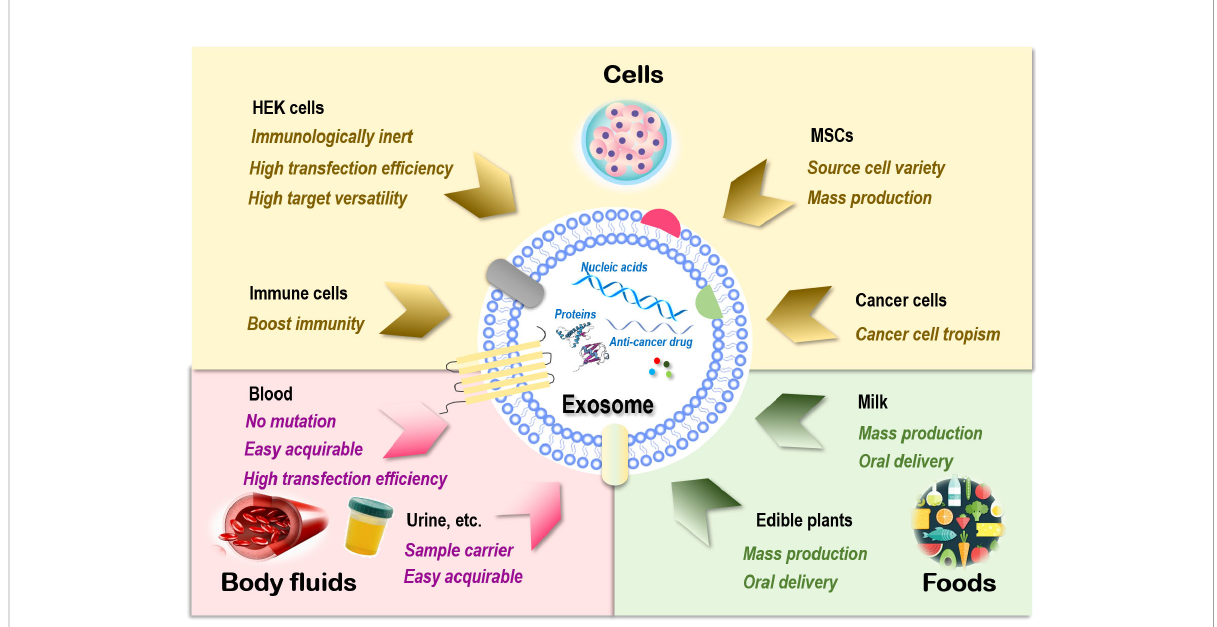
FIGURE 1 Sources of exosomes and their therapeutic advantages for drug delivery. Exosomes can be generated from almost all types of cells. Those are relevant to therapeutics fall into three main categories, i.e., cells, body fl uids, and food. There are four major cell sources for exosome generation, i.e., human embryonic kidney (HEK) cells, mesenchymal stem cells (MSCs), immune cells, and cancer cells. Exosomes of HEK cell origin are immunologically inert without safety concerns, have high transfection ef fi ciency, and can deliver drugs to various target tissues. Exosomes derived from MSCs can be easily obtained from a variety of human tissues and expanded ex vivo in large scale. Exosomes originated from immune cells can enhance the anticancer ef fi cacy of its entrapped drugs by boosting the immunity. Exosomes derived from cancer cells have the tropism toward their parental cells and thus can be used as Trojan horses to target these malignant cells. Exosomes derived from blood have a low risk of unexpected mutations, are easily acquirable, and have higher transfection ef fi ciency. Exosomes isolated from other body fl uids such as urine, saliva, and amniotic fl uids can be used as parental cell sample carriers for disease diagnosis. Exosomes derived from food such as milk and edible plants are stable under acidic conditions that can be orally delivered and massively